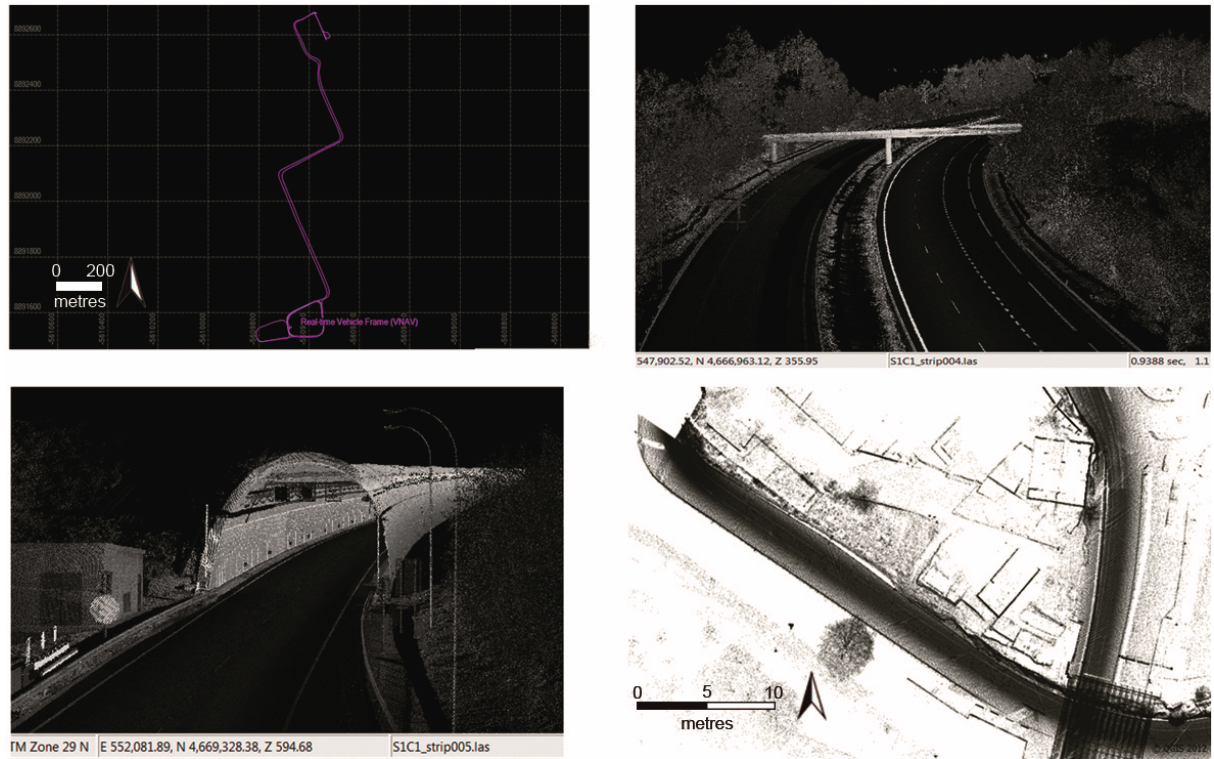
Figure 6. Trajectory and examples of point clouds obtained with the mobile scanning